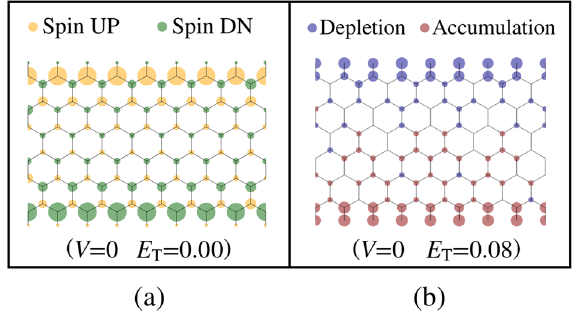
Figure 7. Spin charge distribution for the modeled 6-zGNR under zero bias voltage and zero transverse electric field (left, yellow represents net spin UP and green represents net spin DN). At zero bias, change in the total charge ( Q UP + Q DN ) due to the application of a transverse electric field of magnitude E T = 0.08V / Å (right, red indicates charge accumulation and blue indicates charge depletion).